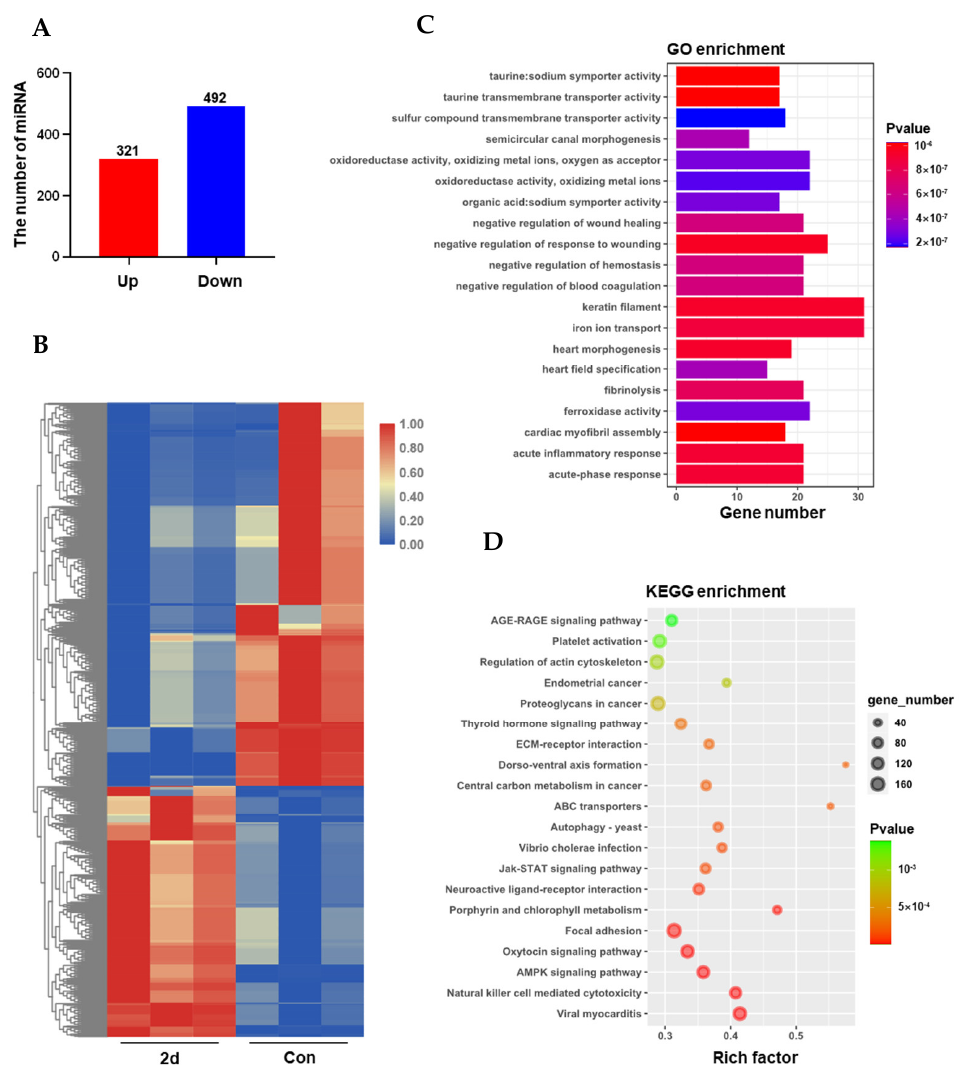
Figure 5. miRNA analysis reveals that AMPK signaling was active in glucose and lipid metabolism under hypothermia exposure. ( A ) up-and down-regulated differentially expressed miRNAs; ( B ) Hi- erarchical clustering of differentially expressed miRNAs among the 6 libraries; ( C ) GO enrichment of differentially expressed miRNAs 2 d vs. Con; ( D ) KEGG enrichment of differentially expressed miRNAs 2 d vs. Con.